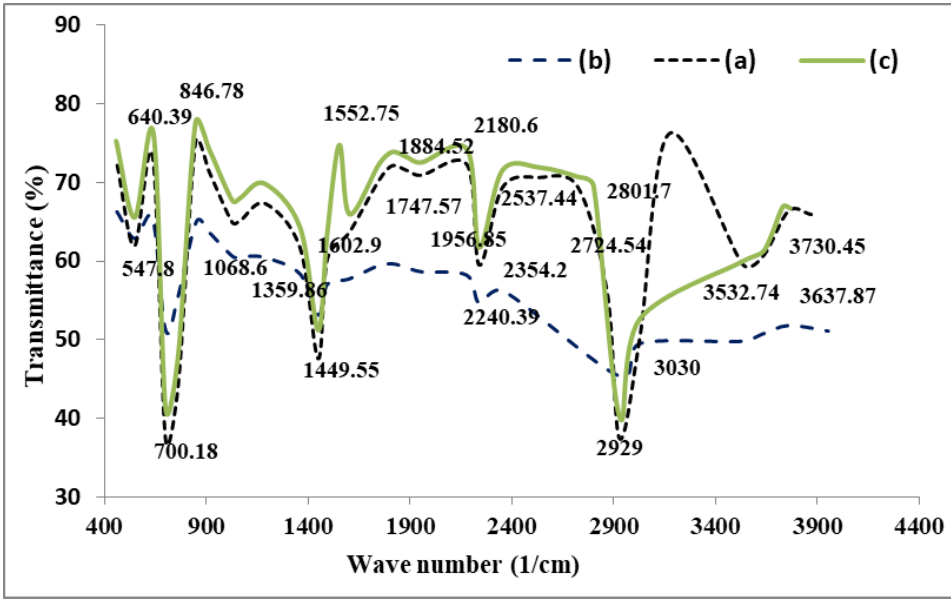
Figure 2. FTIR band assignment of the synthesized P(AN- co -St) ( a ), SP(AN- co -St) ( b ) and P (AN- co -St)/MWCNTs ( c ).